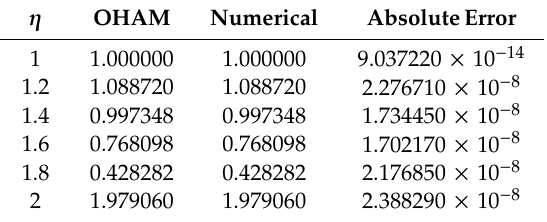
Table 6. OHAM and numerical comparison for f ( η ) . When Pr = 7.7, β = 1.5,Re = 1.4, φ = 0.01.